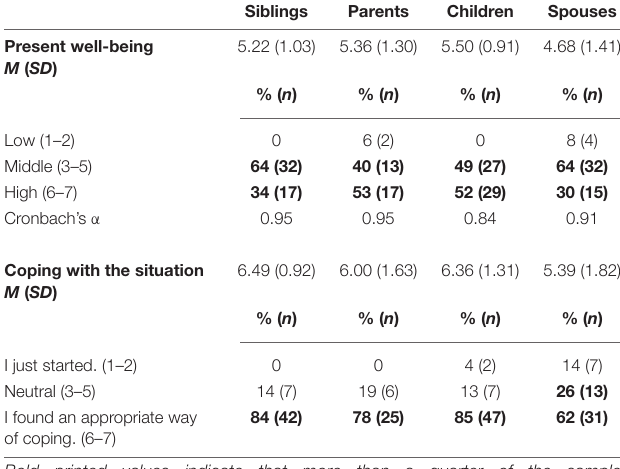
TABLE 5 | Present well-being (seven items, Dalbert, 1992) and state of coping with the situation. Siblings Parents Children Spouses Present well-being M ( SD )